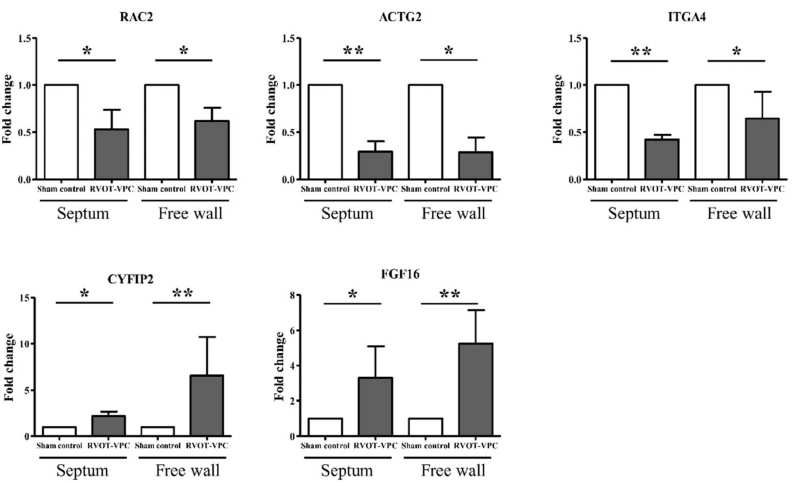
Figure 5. Five differentially expressed genes related to actin cytoskeleton signaling induced by 6-month RVOT bigeminy VPCs in the septum and free wall of left ventricle. Five genes that were differentially upregulated or downregulated in the RVOT-VPC group compared to the sham control group according to next generation sequencing analysis results were selected and studied. The expressions of RAC2, ACTG2, and ITGA4 were downregulated while the expressions of CYFIP2 and FGF16 were upregulated in the RVOT-VPC group compared to sham control group. *: p < 0.05 and **: p <